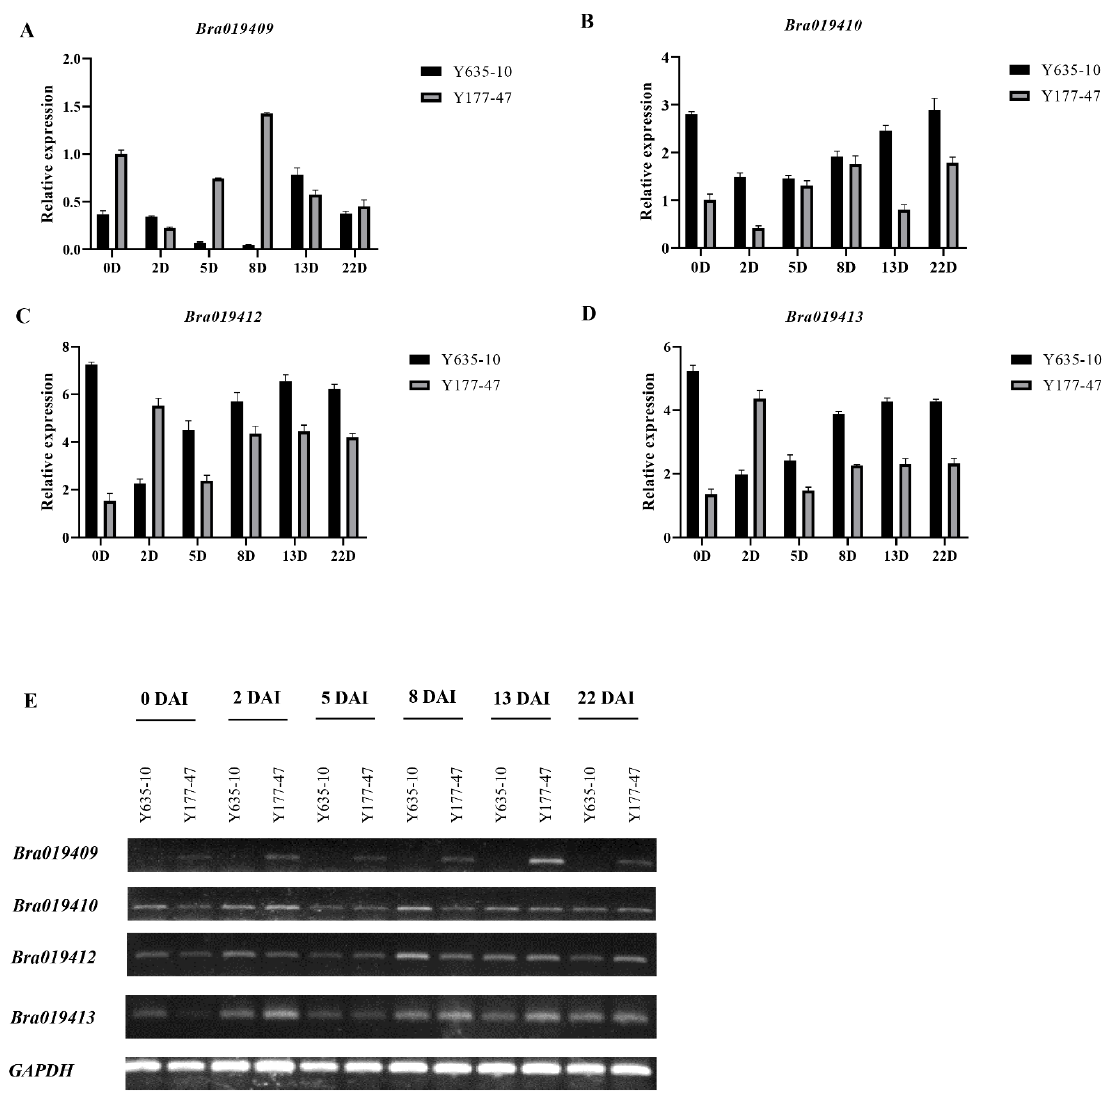
Figure 3. The expression levels estimated by qRT-PCR of Bra019409 , Bra019410 , Bra019411 and Bra019412 at different days after inoculation (DAI) in Y635-10 and Y177-47 ( A ) Bra019409 ; ( B ) Bra019410 ; ( C ) Bra019412 ; ( D ) Bra019413 . ( E ) The differential expression predicted by RT-PCR of Bra019409, Bra019410 , Bra019412 , Bra019413 in resistant and susceptible materials at different pe- riods.